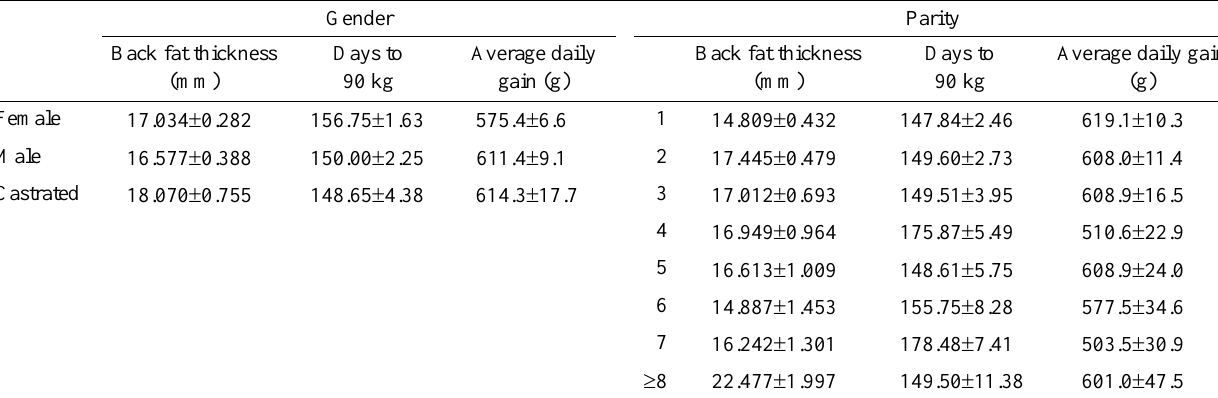
Table 3. Least square means of back fat thickness, days to 90 kg and average daily